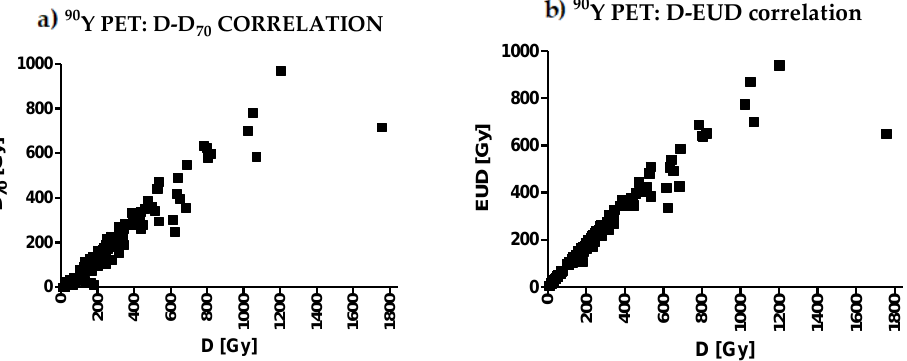
Figure 5. Two visual examples of correlations between the mean lesion absorbed dose D ( X axis) and ( a ) D 70 and ( b ) EUD.